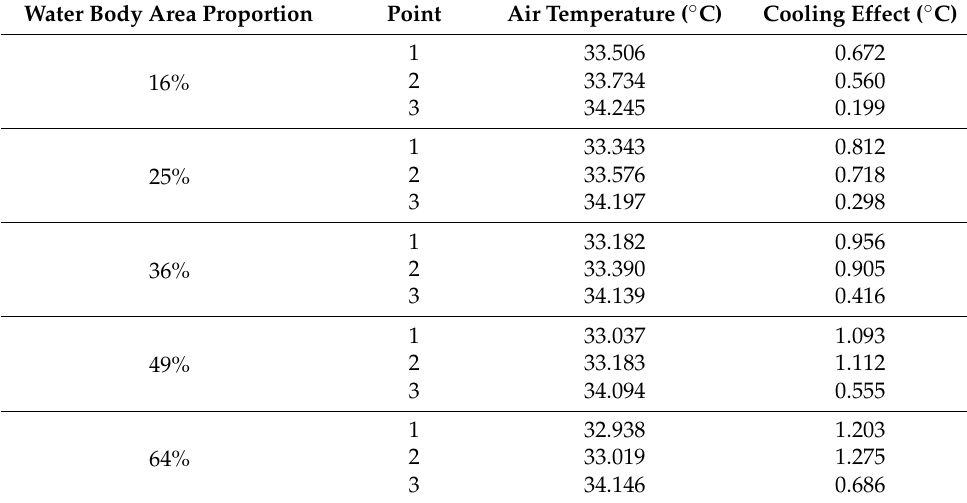
Table 4. Air temperature and cooling effect for each point.